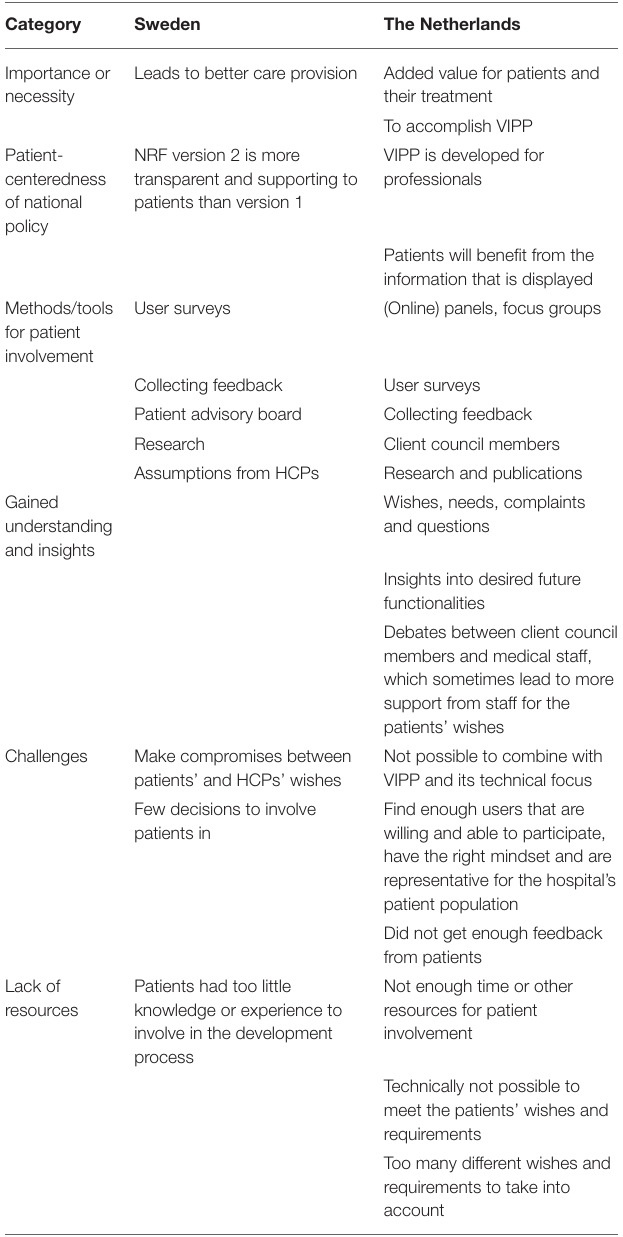
TABLE 8 | Patient involvement on the local implementation level.